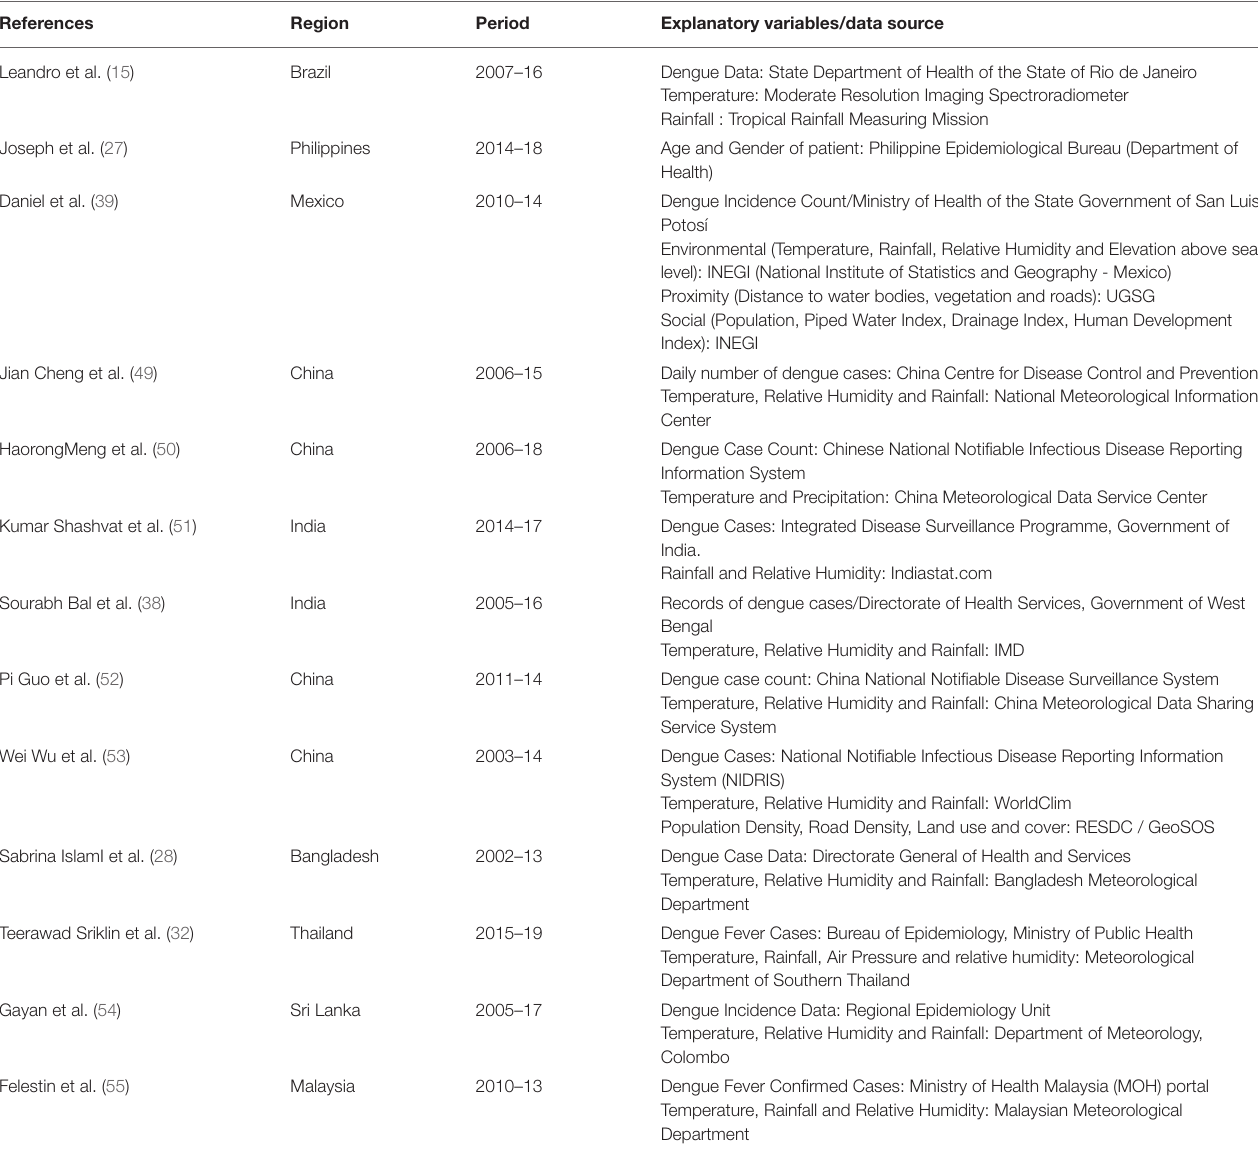
TABLE 1 | Detailed representation of explanatory variables and data sources of different